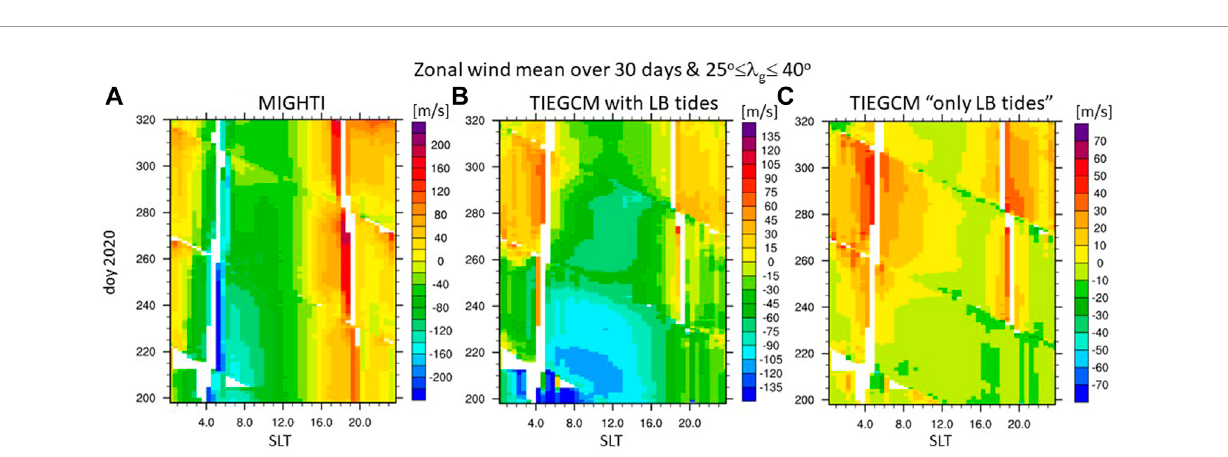
FIGURE 3 Zonal wind [m/s] at 250 km averaged over 30 days and between geographic latitudes λ g of 25 o ≤ λ g ≤ 40 o (A) . MIGHTI zonal wind, (B) . TIEGCM with LB tides sampled as MIGHTI winds, (C) . TIEGCM only due to LB tides.